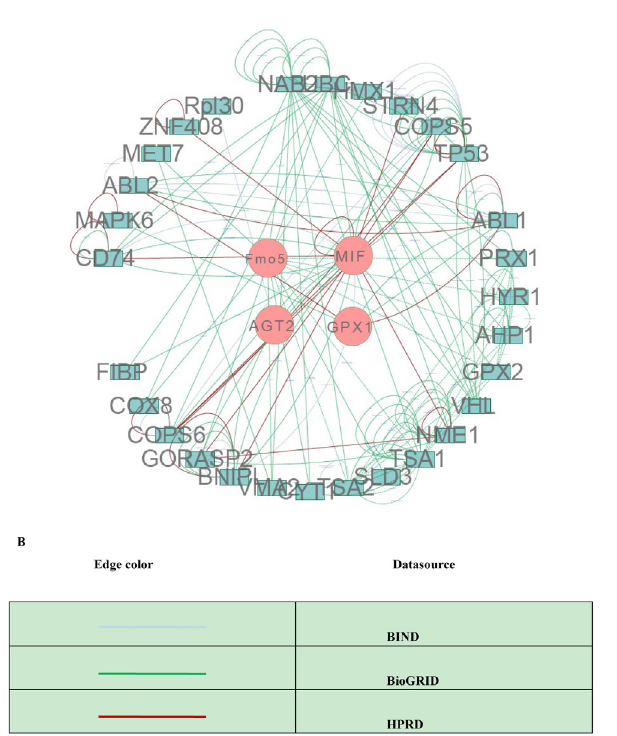
FIGURE 3 - Network of downregulated shared genes. (A) Network of downregulated shared genes based on Cytoscape v 3.5.1 software; (B) Red circular nodes in the center of the network represent downregulated genes common to hypertension, diabetes and hyperlipidemia. The outer ring was constructed by green rectangular nodes of first neighbor genes of those in